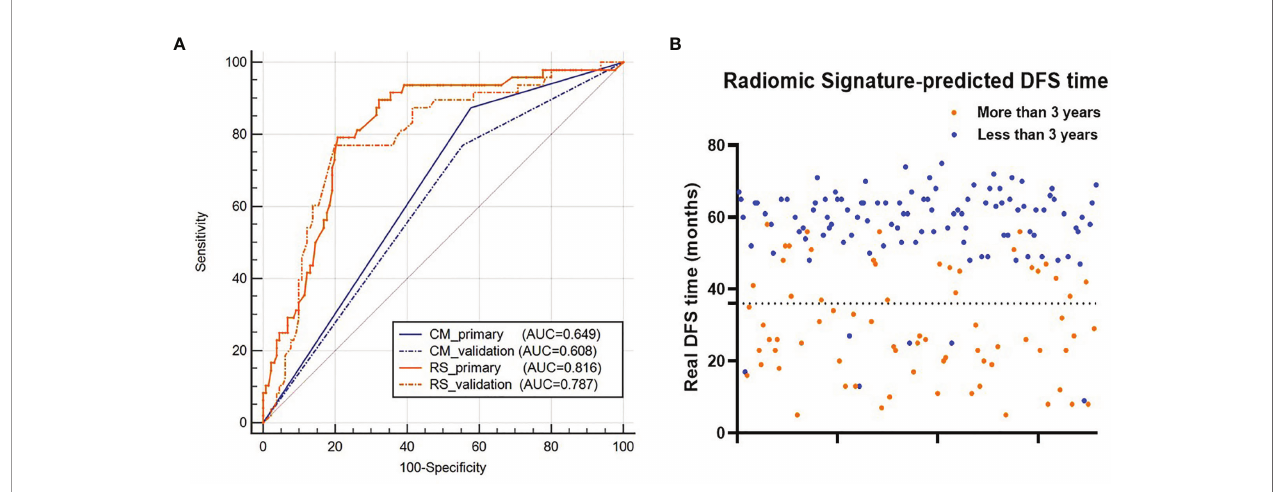
FIGURE 6 | (A) ROC curves of the two models for 3-year DFS probability prediction. (B) Distribution of the DFS time for patients. The orange dots represent patients who are predicted to have DFS time longer than 3 years by the RS, and the blue dots represent patients who are predicted to have DFS time less than 3 years by the RS. RS represents radiomic signature; CM represents clinical model; ROC represents receiver-operating characteristics; DFS represents disease-free